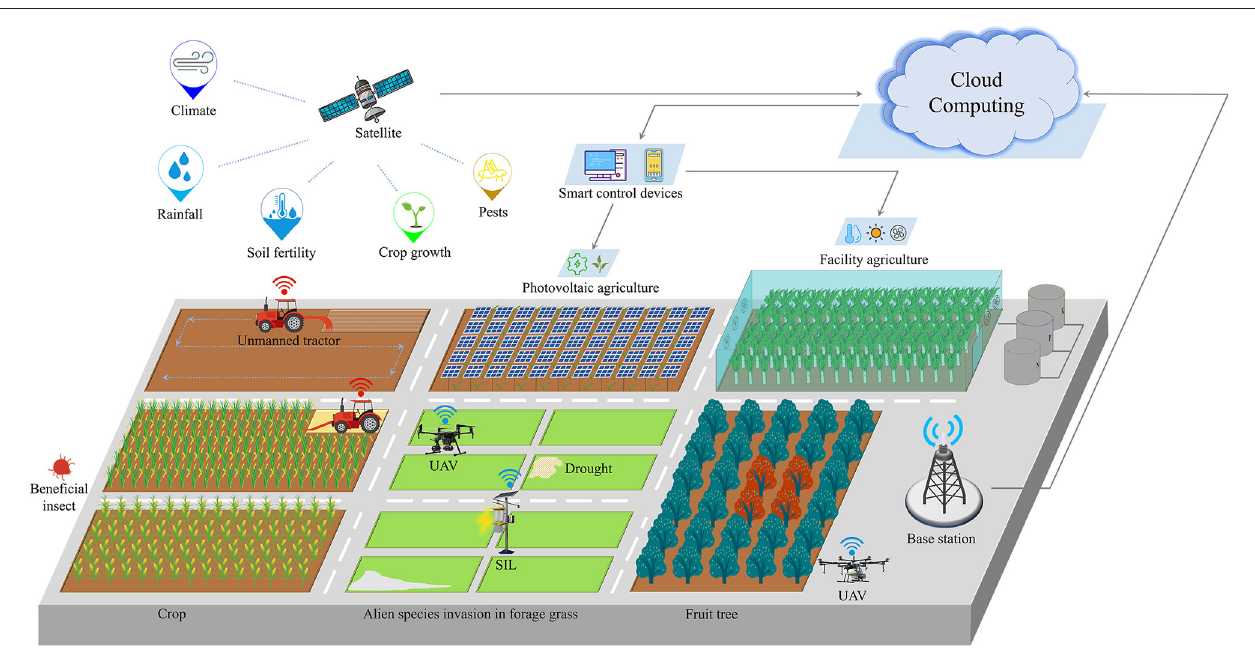
FIGURE 1 | The era of unmanned smart plant